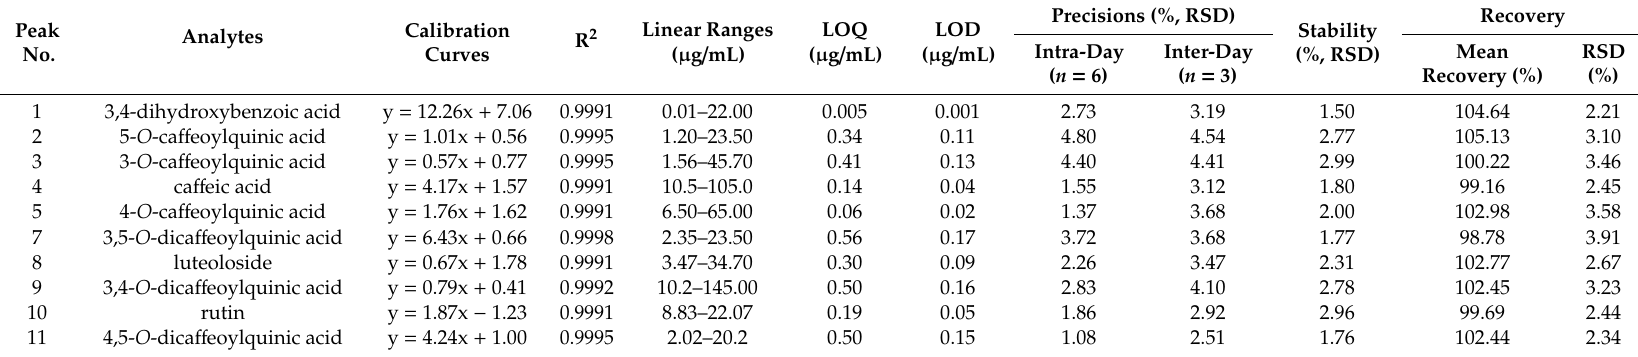
Table 2. Regression equations, linearity ranges, correlation coe ffi cients, limits of quantitation (LOQ), limits of detection (LOD), and inter-day and intra-day precisions and stability for 12 analytes using the QDa detector.